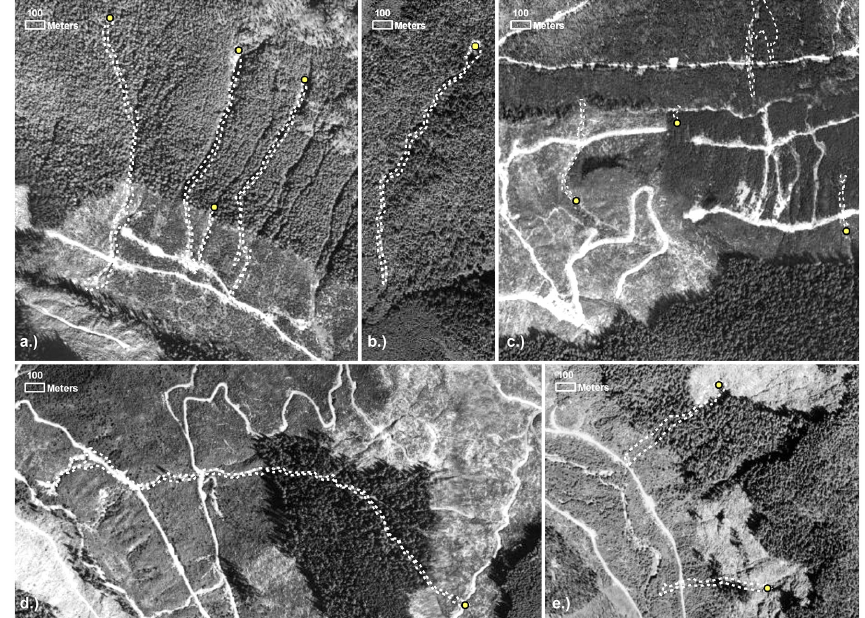
Figure 2. Examples of landslides in the inventory in a variety of forest cover conditions. The white-dotted polygon lines outline the landslide shape, and the solid-yellow circle points show the mapped location of landslide initiation. (a) Debris flows initiated in closed forest and extend into semi-open forest. (b) Debris flow occurring entirely in closed forest. (c) Debris slides initiated adjacent to roads in open and semi-open forest. (d) Debris flow initiated in adjacent to a forest road in open forest and travels through closed forest and semi-open forest conditions. (e) Debris slides initiated in open forest. Bing Maps Aerial © 2013 Microsoft Corporation; data are © 2010 DigitalGlobe Image courtesy of USGS, © 2010 GeoEye and © 2010 the province of British